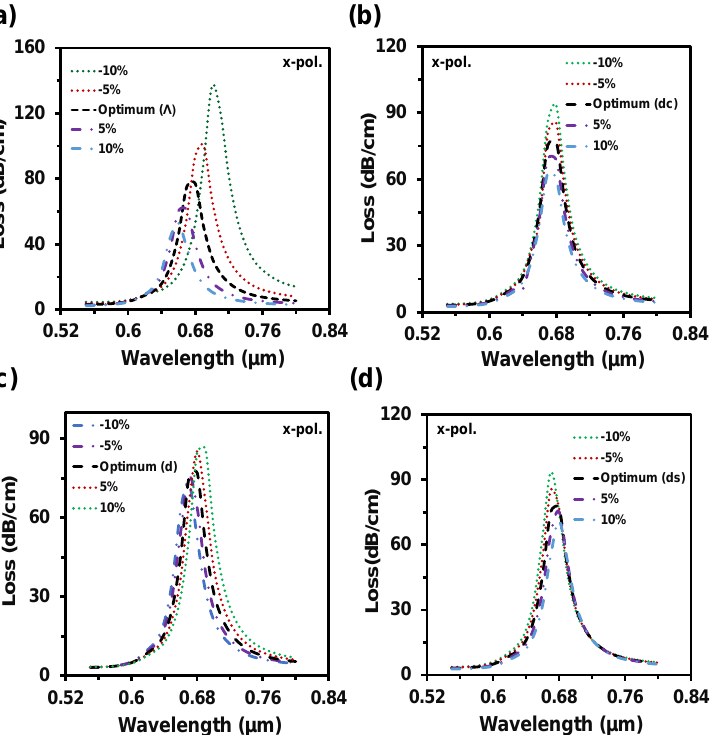
Figure 10. CL spectra with the structural parameter variation of ( a ) pitch, Λ , ( b – d ) air-hole diameters dc, d, ds up to ± 10% from the optimum value when same analyte RI 1.35 used in both channels. From Figure 10d, the loss depth rose and blue shift happened with the cutback of the diameter ( d s ). The opposite scenario is created by scaling up the small air-hole diameter. According to the fabrication tolerance investigation, it is visible that even if the parameters fluctuate up to ±10%, it will not the hamper the sensing performances. Table 2 shows a performance comparison between the proposed sensor and the existing reported sensors. It seems that performance of the proposed sensor is extremely high compared with other reported multianalyte detection-based PCF-SPR sensors. From Table 2, most of the re- ported sensors have only investigated the sensing performance in term of wavelength in- terrogation method. Besides, the proposed sensor was investigated by wavelength and amplitude interrogation methods. Additionally, we figured out all the sensing perfor- mance (see Table 1) considering all the important performance measurement parameters, which bring out the sensing accuracy. Table 2. Performance comparison of the proposed multi-channel PCF sensor with the reported sen- sors. Ref